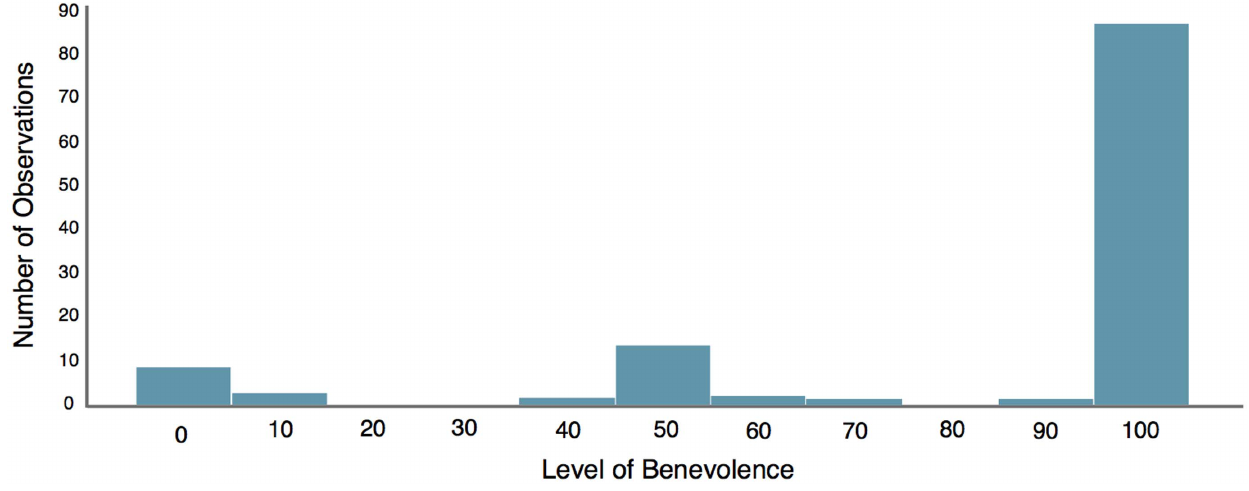
Figure 1. Distribution of choices in BT ( $ 0 : 10, $ 1) of those people acting as Player 1. Only 12 out of 123 participants acted in a malevolent or inequity averse way; all others acted benevolently with a large majority of participants acting in a perfectly benevolent way.